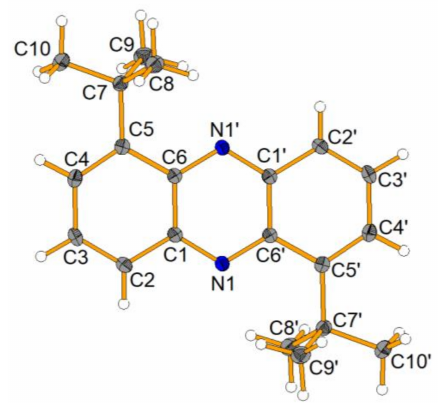
Figure 1. Molecular structure of the isolated phenazine 16 , showing 50% probability